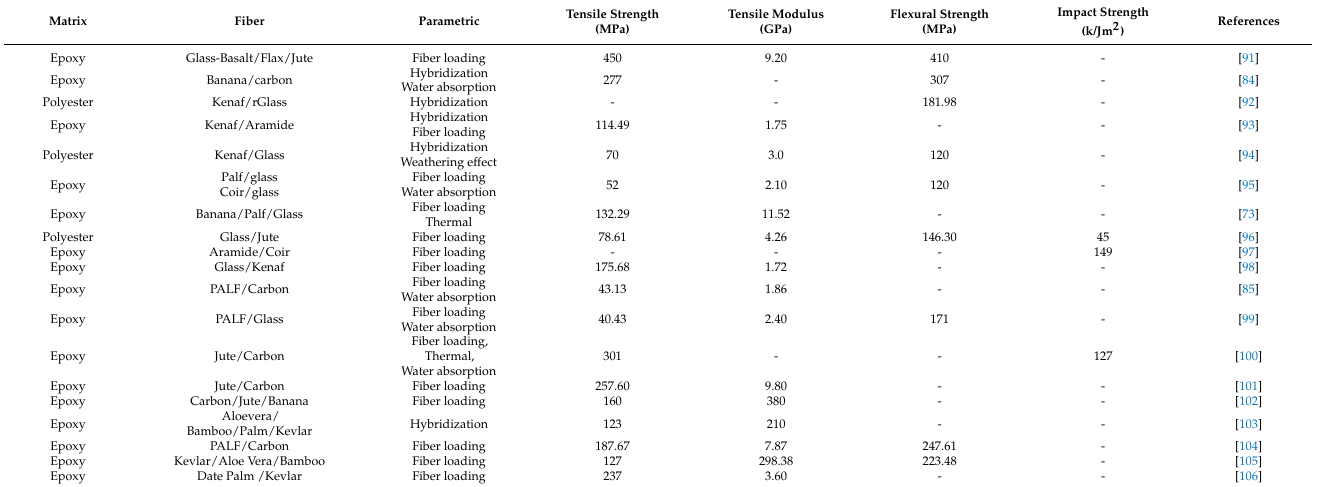
Table 7. Research works reported on mechanical properties of natural-synthetic hybrid